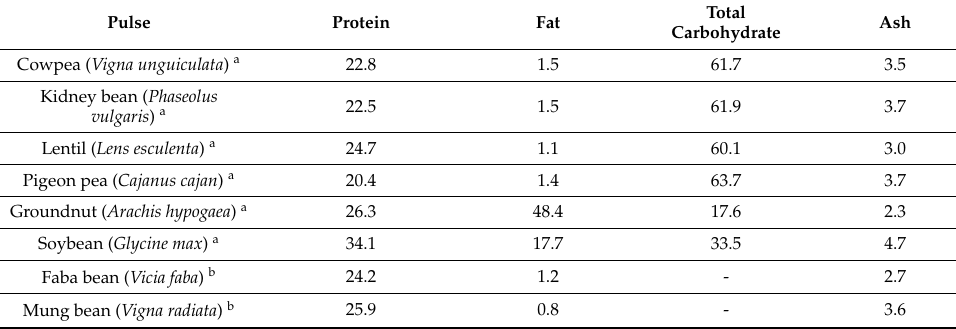
Table 2. Proximate composition of selected legumes.